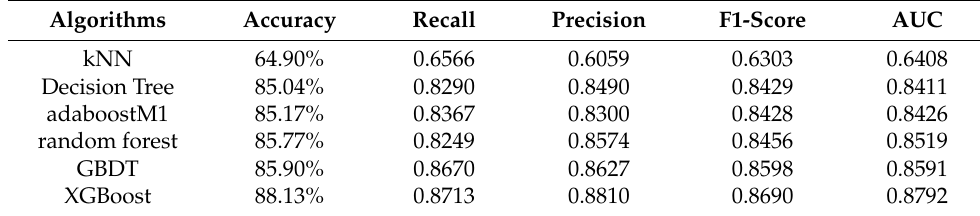
Table 4. Overall result performance of all algorithms (15 features).